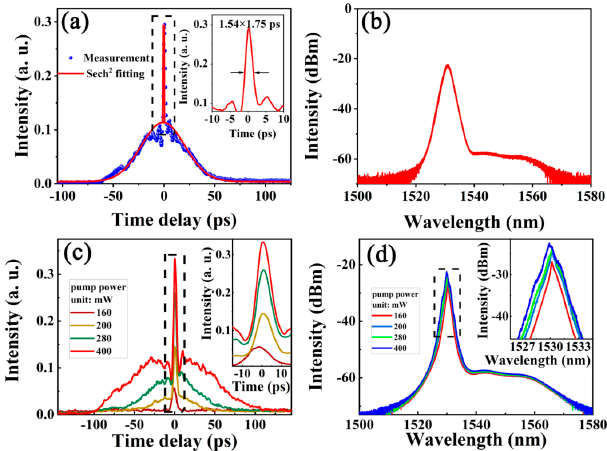
Figure 4. Function of experimental NLP characteristics and NLP behavior with pump power. ( a ) Typical NLP AC trace at the pump power of 280 mW, inserted shows the NLP spike area; ( b ) the corresponding spectrum; ( c ) NLP behavior with increasing pump power from 160 mW to 400 mW, inserted shows the NLP spike area; ( d ) the corresponding spectra evolution with zoomed-in NLP spectra.